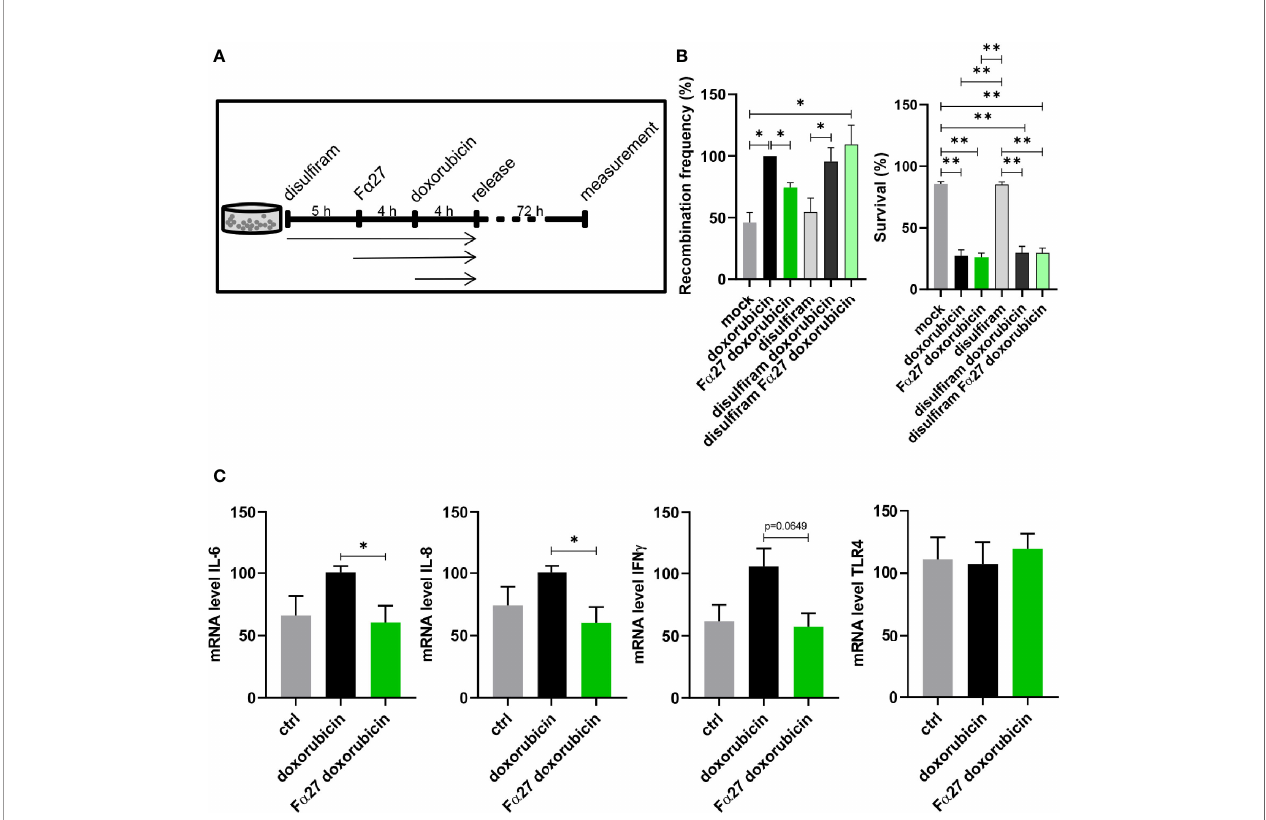
FIGURE 6 | Involvement of NF k B and TLR4 in F a 27 signaling. (A) Scheme for doxorubicin treatment protocol following exposure to the NF k B inhibitor disul fi ram. WTK1MLL cells were treated for 5 h with 4 µM disul fi ram followed by inclusion of 10 µg/ml F a 27 for 4 h and 0.5 µM doxorubicin for another 4 h. Then the cells were released by washing with PBS and seeded in fresh medium. (B) In fl uence of disul fi ram under F a 27 and doxorubicin treatment. The recombination frequency measured by FACS showed a decrease of doxorubicin-induced MLL bcr rearrangements by F a 27 treatment (six independent experiments). This effect was lost in the presence of disul fi ram. Mean recombination frequencies of doxorubicin treated cells were set to 100% each (absolute mean: 1.6x10 -5 ). The panel in the right shows that survival was affected by doxorubicin but not by disul fi ram. Data are represented as mean +SEM (*p < 0.05; **p < 0.01). (C) qRT-PCR of TLR4 downstream genes. The cells were treated with 10 µg/ml F a 27 for 4 h, 0.5 µM doxorubicin included for 4 h, total RNA isolated and mRNA subjected to qRT-PCR. Doxorubicin treatment increased mRNA expression of IL-6, IL-8 and IFN g , whereas F a 27 reduced these doxorubicin-induced levels (n=5-6 obtained in three independent experiments). TLR4 mRNA expression was not changed. Statistical signi fi cances were calculated for doxorubicin-treated cells using Mann-Whitney-U test (*p < 0.05) and values are represented as mean +SEM. See also Figures S4 and S5 ( Figure 7B ). To strengthen this result, the corresponding experiment was also performed with WTK1 cells showing comparable results ( Figure S7 ). For comparison, PLA signals for the DNA repair proteins Ku70 andKu80 were limitedtothe DAPI- stainednucleus.RaisingtheconcentrationoftaggedF a 27increased the average numbers offoci per cell, reaching statistical signi fi cance after incubation with C-terminally tagged peptide F a 27-Flag.